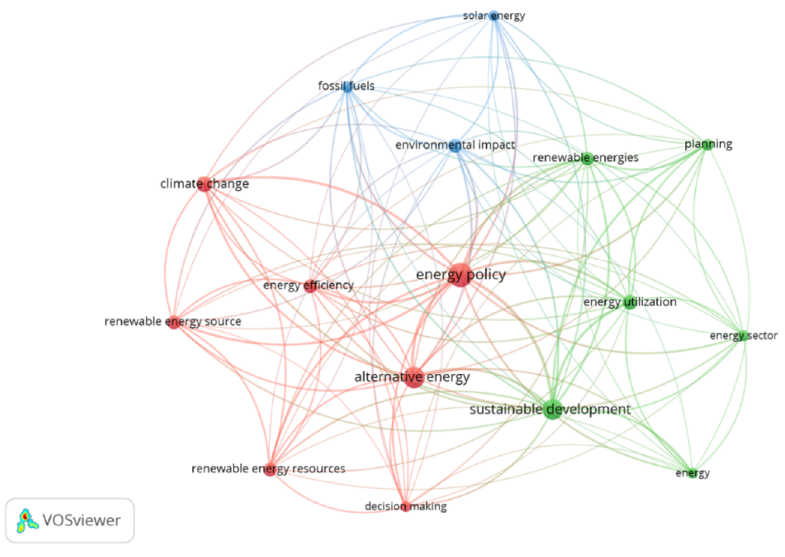
Figure 10. Bibliometric map of index keyword co-occurrence results from Scopus based on Query 26. The authors’ elaboration was performed in VOSviewer (version 1.6.18).